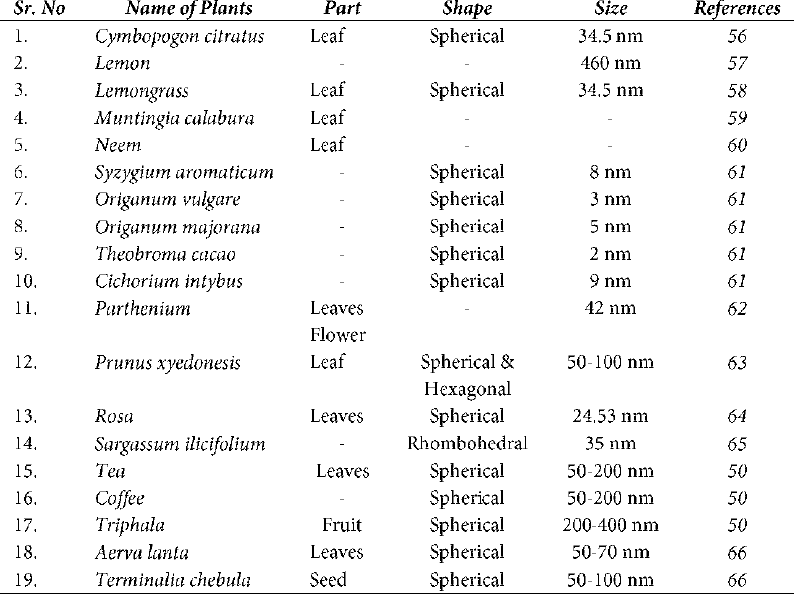
PROTOCOL FOR BIOSYNTHESIS OF Al